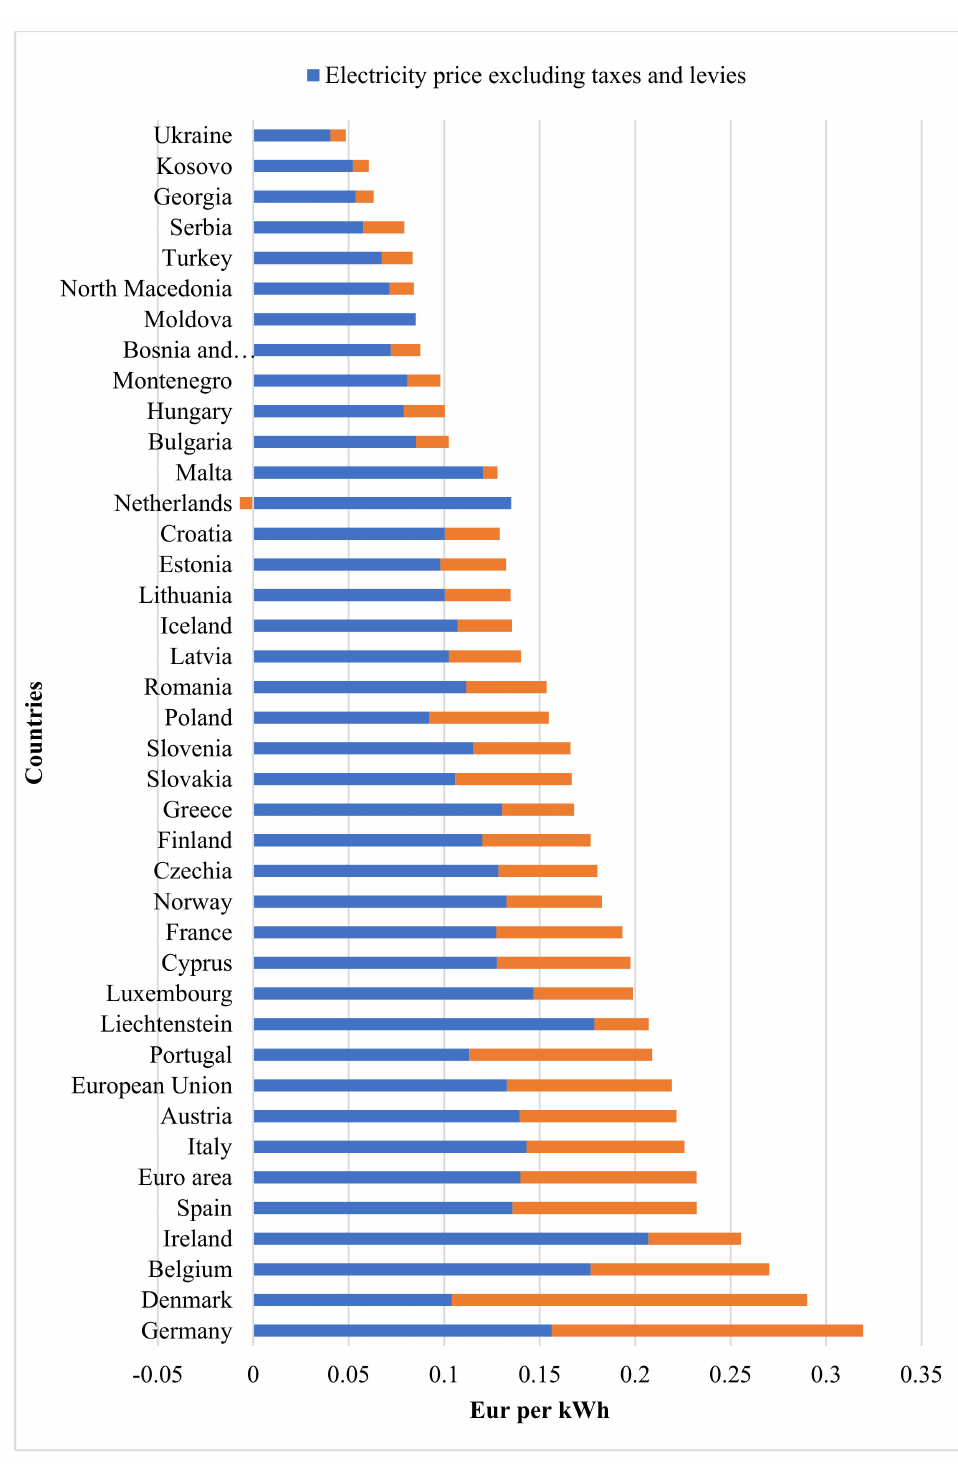
Figure 13. Electricity prices for household consumers in the EU, first half 2021 (created by the authors, based on